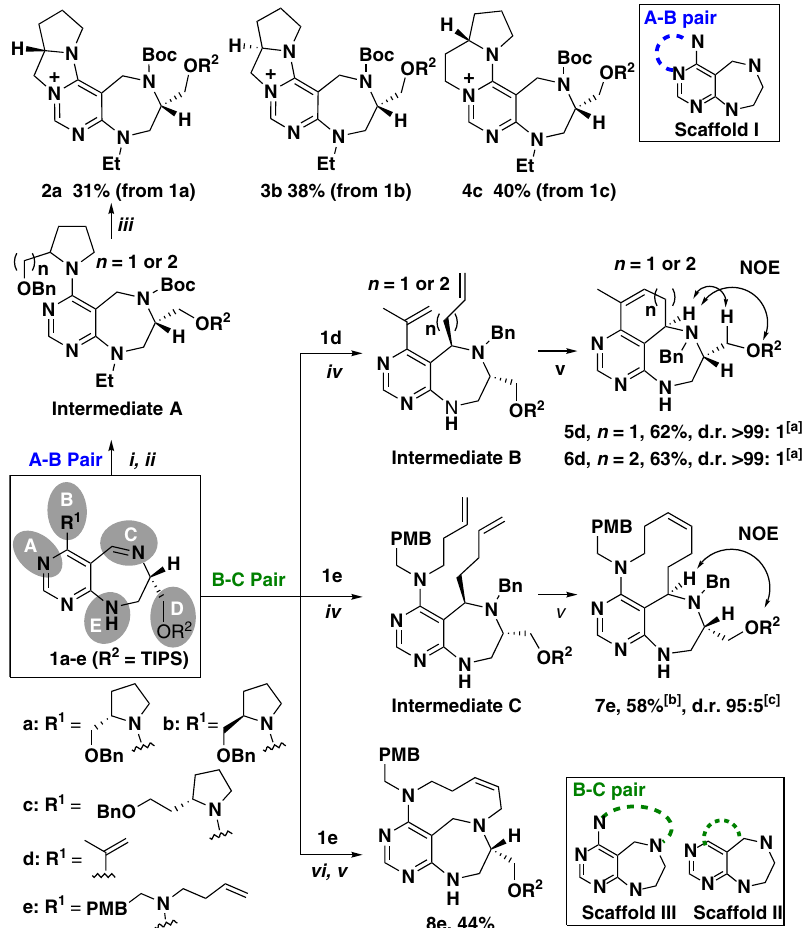
Figure 2 | A–B and B–C paring pathways for synthesis of scaffolds I–III. Reagents and conditions: ( i ) NaBH 4 , MeOH, 0 (cid:2) C - r.t. then Boc 2 O, TEA, DCM, 0 (cid:2) C - r.t.; ( ii ) EtI, NaH, DMF, 0 (cid:2) C - r.t.; ( iii ) Pd(OH) 2 /C, H 2 , MeOH, then MsCl, TEA, DCM, 0 (cid:2) C - r.t.; ( iv ) BnBr, ACN, 80 (cid:2) C, then RMgBr, THF, (cid:2) 78 (cid:2) C - r.t.; ( v ) Grubbs’ second-generation catalyst (20mol%), toluene, reflux; and ( vi ) NaBH 4 , MeOH, 0 (cid:2) C - r.t., then allyl bromide, TEA, DMF, 0 (cid:2) C - r.t. TIPS, triisopropylsilyl; TEA, triethylamine; MsCl, methanesulfonyl chloride; BnBr, benzyl bromide; ACN, acetonitrile. [a] Determined by LC-MS analysis of crude reaction mixture and by 1 H NMR analysis of samples purified by short silica-gel column. [b] Yield of the isolated major diastereomer. [c] Determined by LC-MS analysis of crude reaction mixture. 1 H NMR, proton nuclear magnetic resonance. LC-MS, liquid chromatography-mass